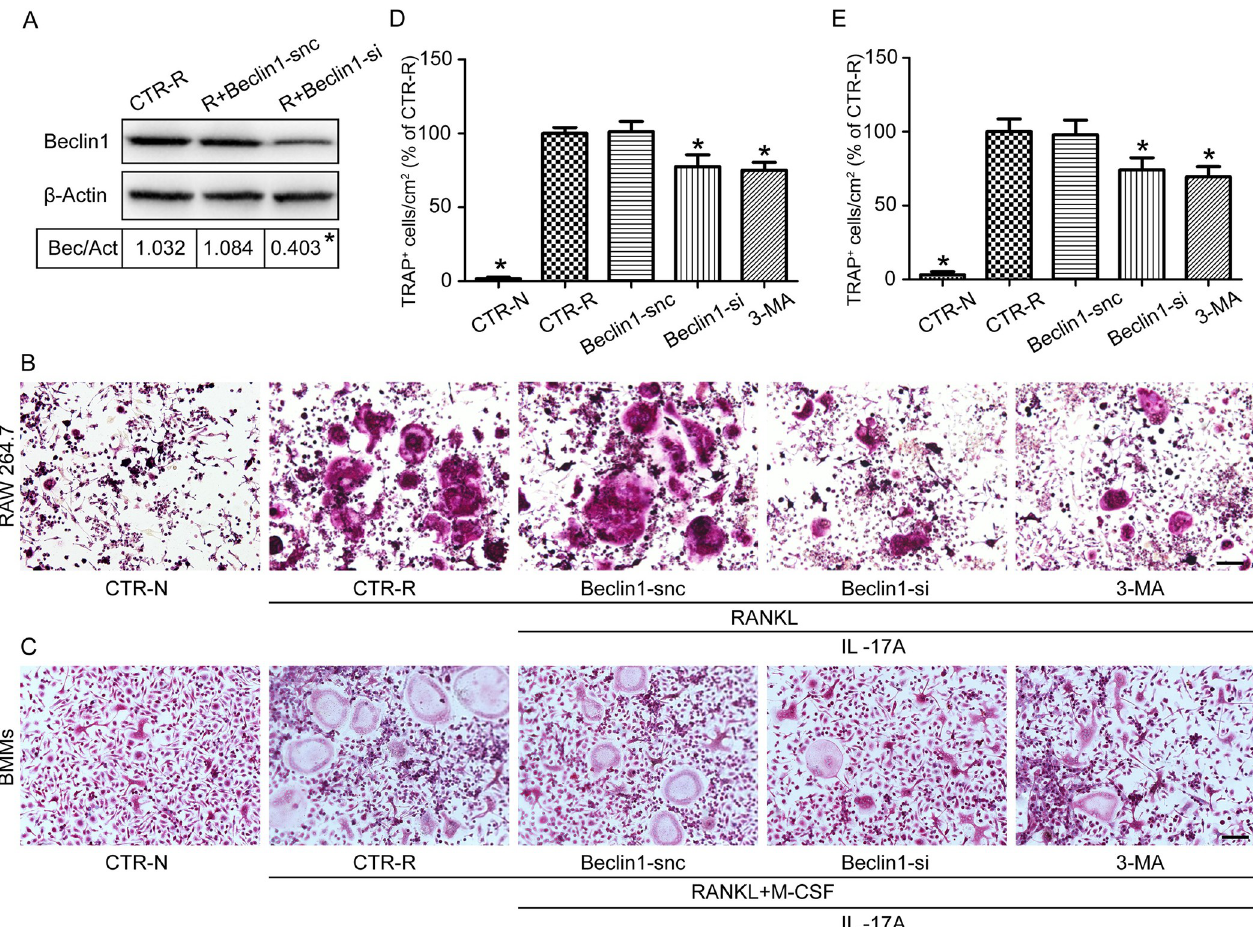
Fig 5. Inhibition of autophagy attenuates IL-17A-mediated osteoclastogenesis. A specific siRNA targeting Beclin1 mRNA was used to knockdown Beclin1 expression. (A) At 24 h post-transfection, the siRNA transfection efficiency was detected by western blotting. Protein expression was normalized against β - Actin. RAW264.7 cells and BMMs were treated with Beclin1-si or 3-MA in the presence of IL-17A (1 ng/ml) and RANKL (50 ng/ml) for 5 d (B, C) and following treatment, TRAP-positive multinucleated cells were quantified (D, E). At least four wells were used for each tested reagent. Cells treated without RANKL and IL-17A (CTR-N) were used as a negative control. Cells treated with RANKL and IL-17A (CTR-R) were used as a positive control and the values are expressed as the mean ± SD. � p < 0.05 compared with CTR-R. Scale bar, 100 μ m.